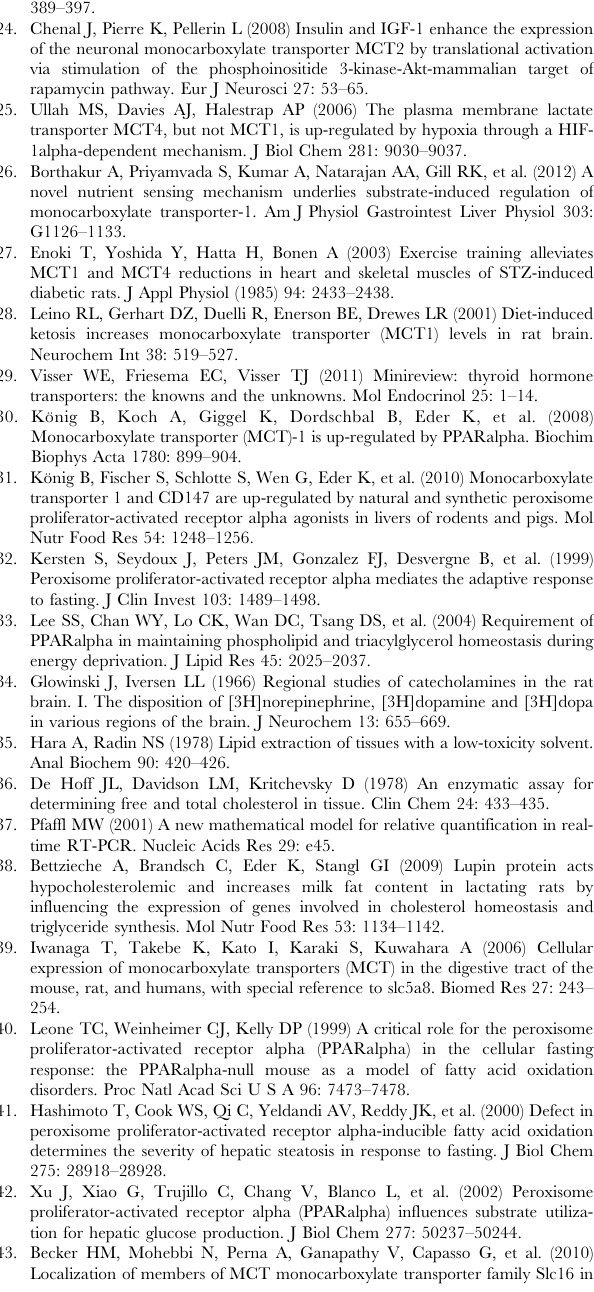
Games Howell test. Horizontal brackets represent differences between groups in post-hoc comparison (** p , 0.001, * p , 0.05).